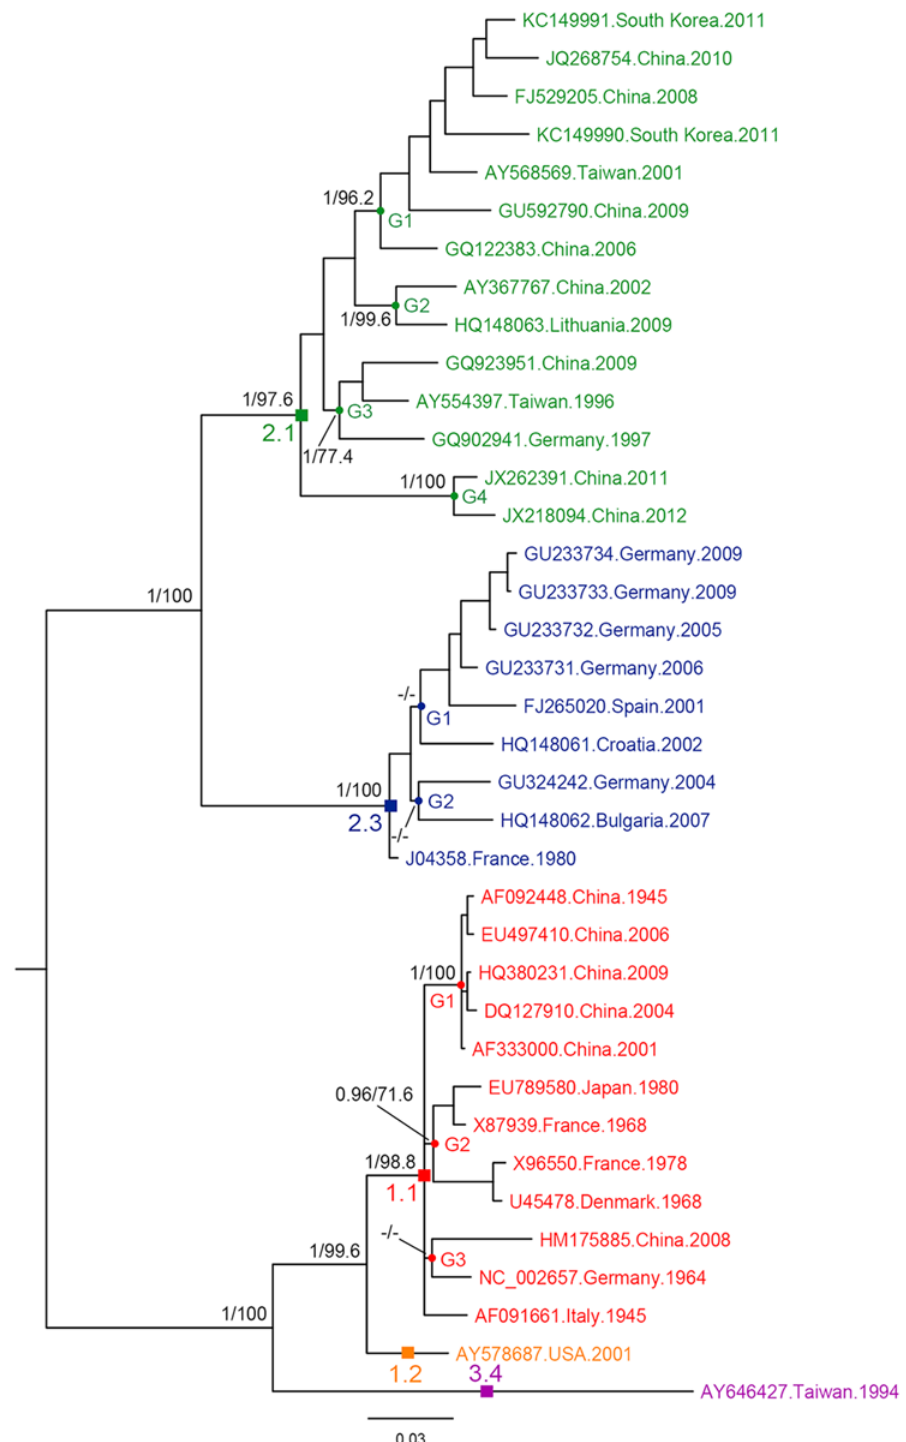
Fig 4. The BI tree based on NS4B sequences of 37 CSFVs. The robustness of the phylogenetic analysis is showed above the nodes: left numbers are Bayesian posterior probabilities ( (cid:1) 0.80) and right ones are ML bootstrap values ( (cid:1) 60%). Subgenotypes and groups are marked above the corresponding nodes using squares and circles.